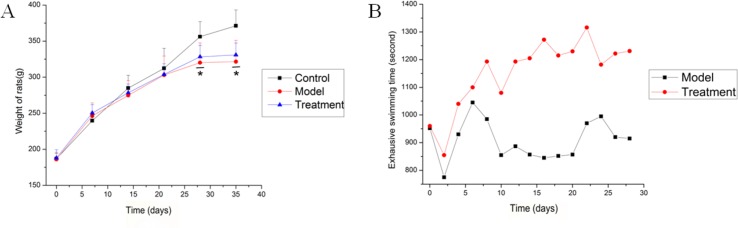
Weight and exhaustive swimming time of rats from the start to the end of the experiment. (A) Weight of rats were measured weekly. Data were described as the mean ± standard deviation for 10 rats in each group. *P < 0.05, compared with the control group. (B) Exhaustive swimming time of the model and treatment groups was measured during the drug intervention period. Data were reported as count for each group. The time was calculated from the point when rats were placed in water to the point when 50% of the rats were exhaustively submerged in water for 10 s.